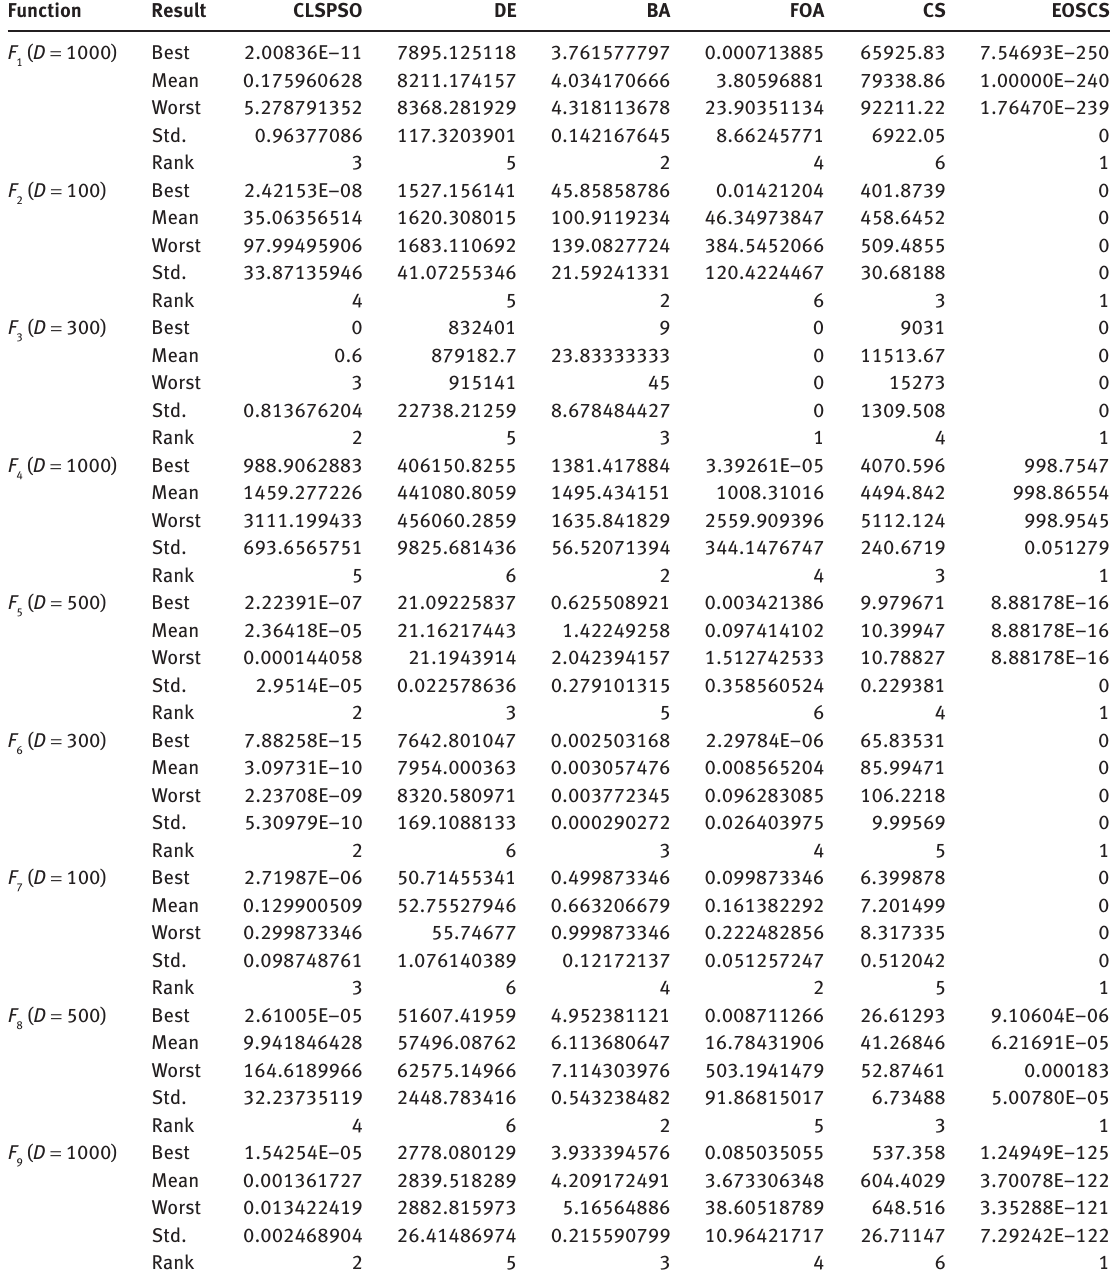
Table 4: Experiment Results of Benchmark Functions for Different Algorithms (high Dimensional).